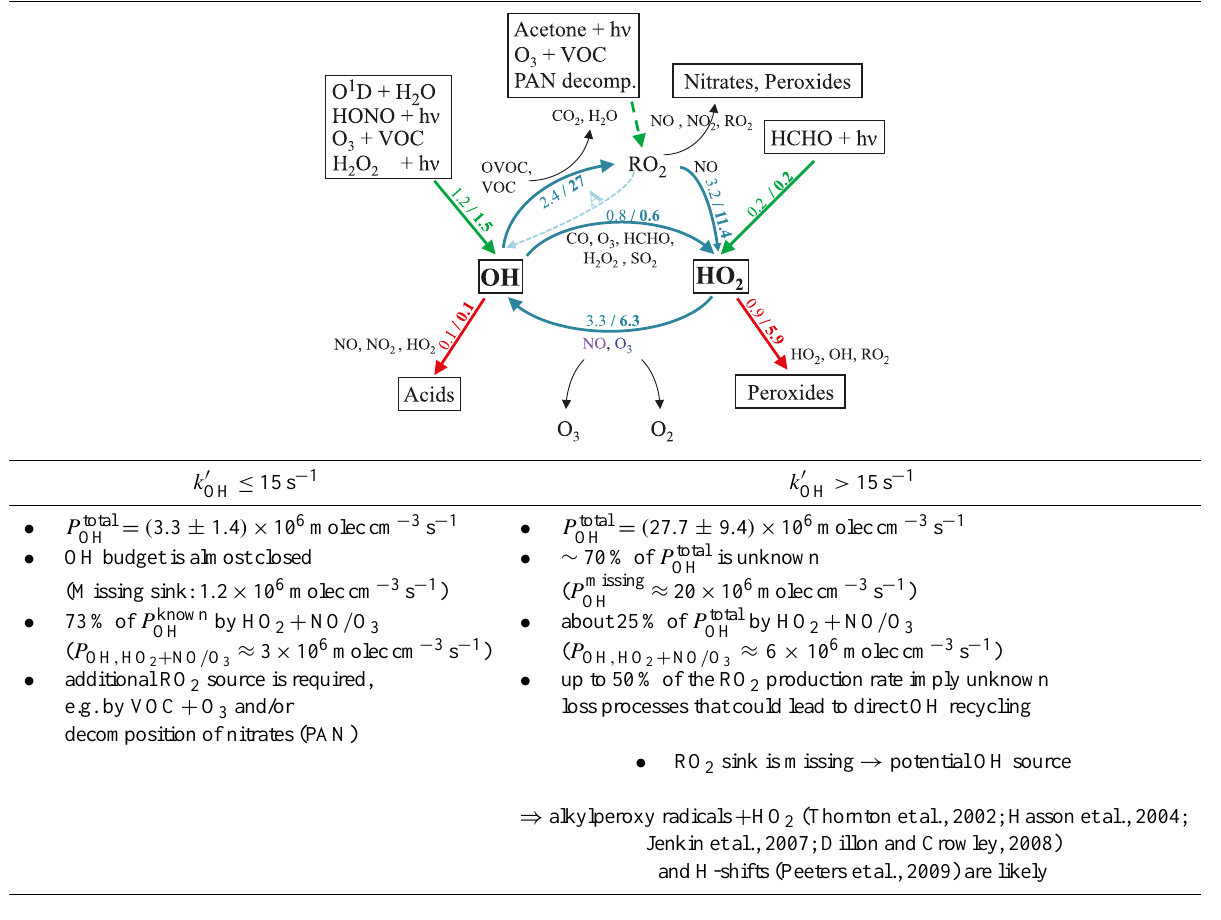
Table 4. HO x budget under different conditions of observed total OH reactivity (moderate/high) during daytime ( J Radical production (green), recycling (blue), and loss (red) pathways are indicated by bold arrows. All rates are given in 10 6 moleccm − 3 s − 1